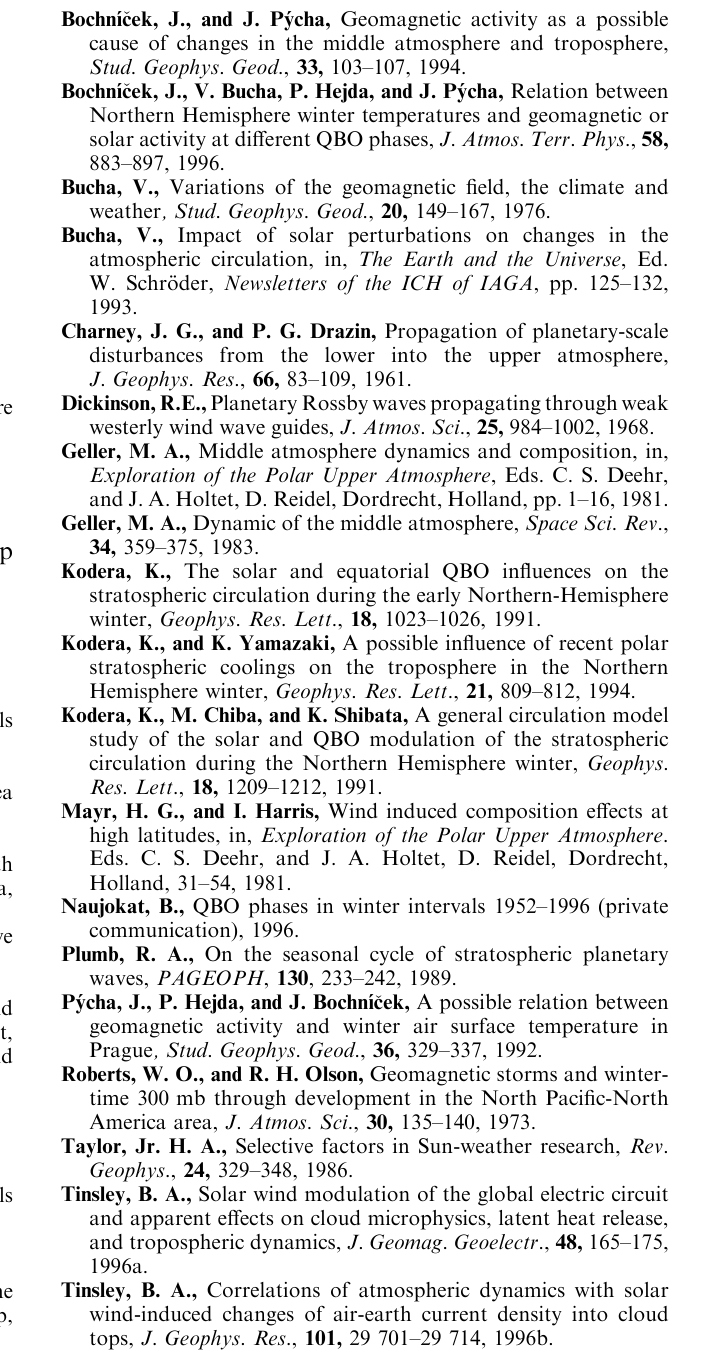
High sum Kp QBO-west High sum Kp